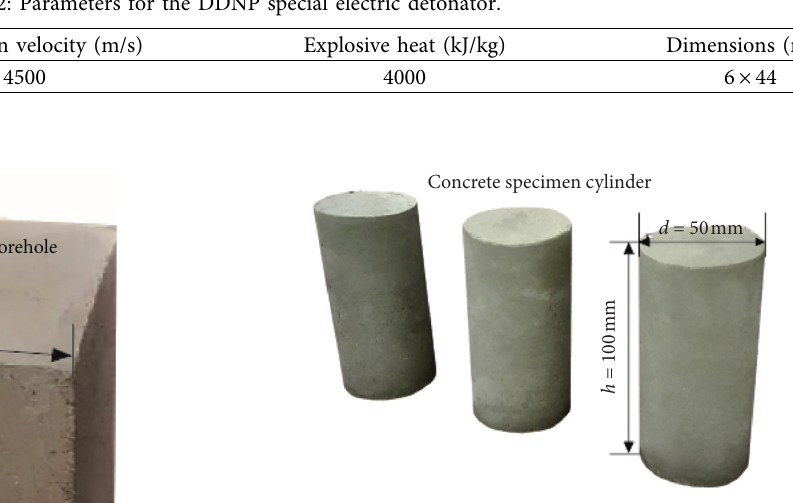
Figure 4: Concrete cylinder specimens.